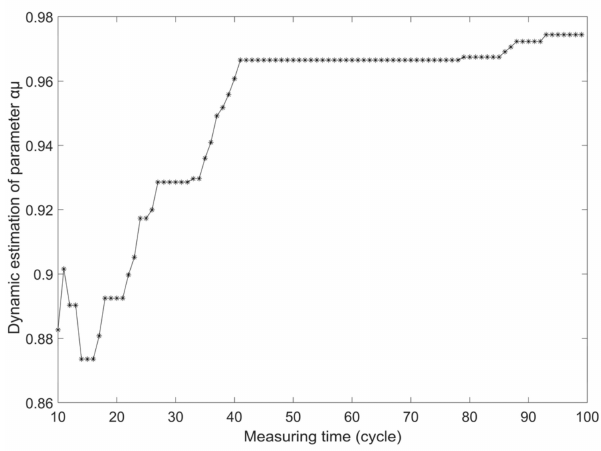
Figure 2. Dynamic estimation of parameter αμ .